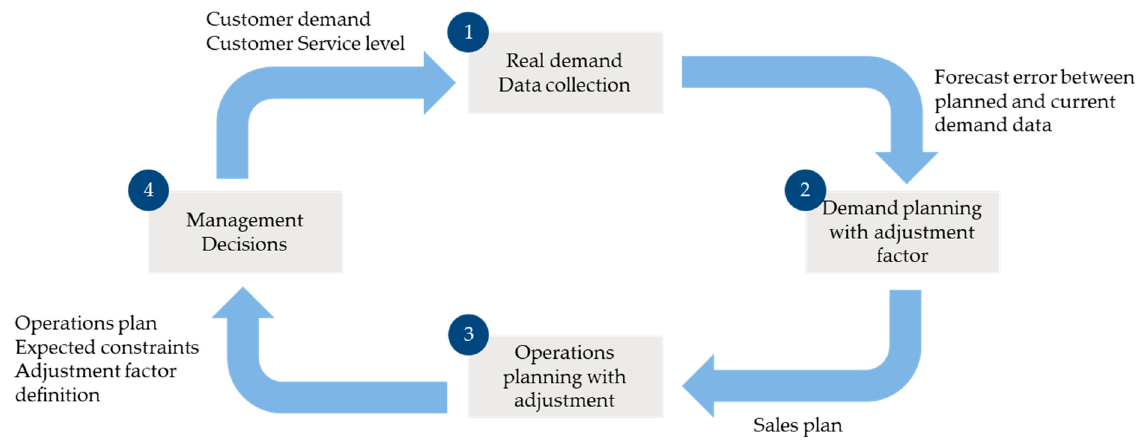
Figure 5. Predictive demand planning and adjustment factors based on real demand data (own elaboration).